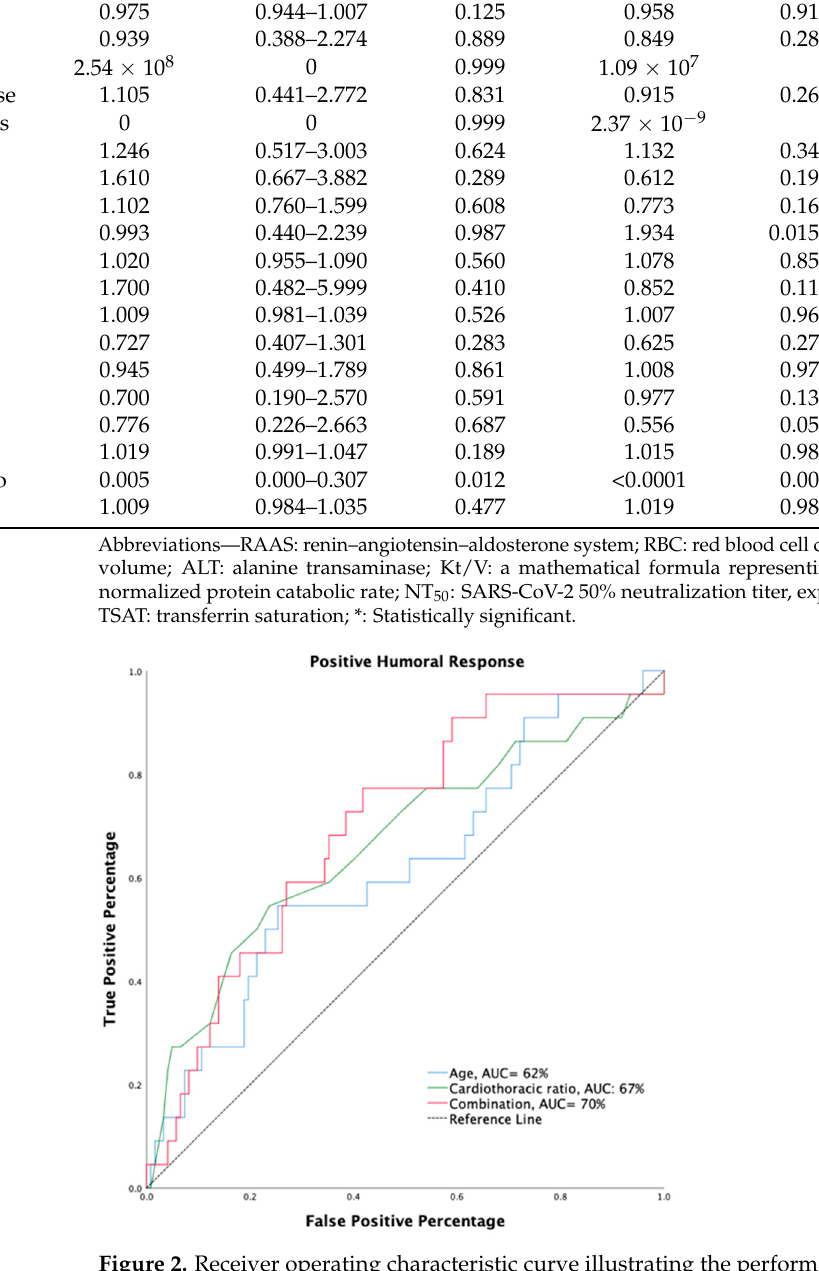
Figure 2. Receiver operating characteristic curve illustrating the performance of age, cardiothoracic ratio, and their combination in predicting the development of NT 50 values over 35.13 IU/mL after a single dose of ChAdOx1 vaccination.